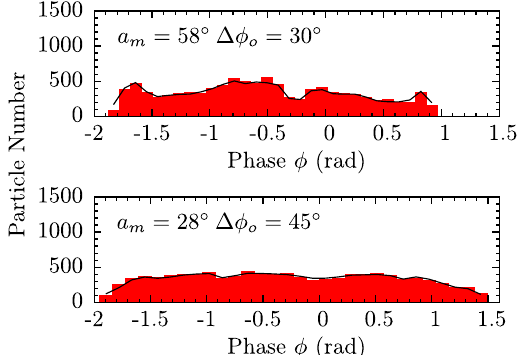
FIG. 21. Parameter map of the rms bunch length as a function FIG. 19. Histogram of 30 bins spanning the entire length of the modulation amplitude and modulation fraction at comparing the linear particle distribution of the two different Δ ϕ ¼ 45 °. The dark blue regions represent particle confinement o double rf settings after diffusion. The black line depicts the turn- where no diffusion occurs. The dark red regions represent by-turn averages of the individual bins 1 × 10 6 revolutions after diffusion occurrence, where the diffusion is unbounded with diffusion, confirming the stability of the structure. particle Fig. 19. Furthermore, the diffusion process converges about twice as quickly, after 6 . 5 × 10 4 revolutions shown in Fig. 20, as opposed to 1 . 5 × 10 5 revolutions. These ¼ 28 °, about half the improvements were attained at a m modulation amplitude compared to the dilution case where Δ ϕ ¼ 30 °. The parameter map of the rms bunch lengths in o ¼ 45 °, shown = ν the a and ν parameter space for Δ ϕ m m s o in Fig. 21, depicts a similar parameter region for beam ¼ 30 °. The dilution as compared to Fig. 13 where Δ ϕ o parameter map of the rms momentum spread exhibits the same features as Fig. 21 with range 0 . 5 ≲ σ δ ≲ 0 . 7